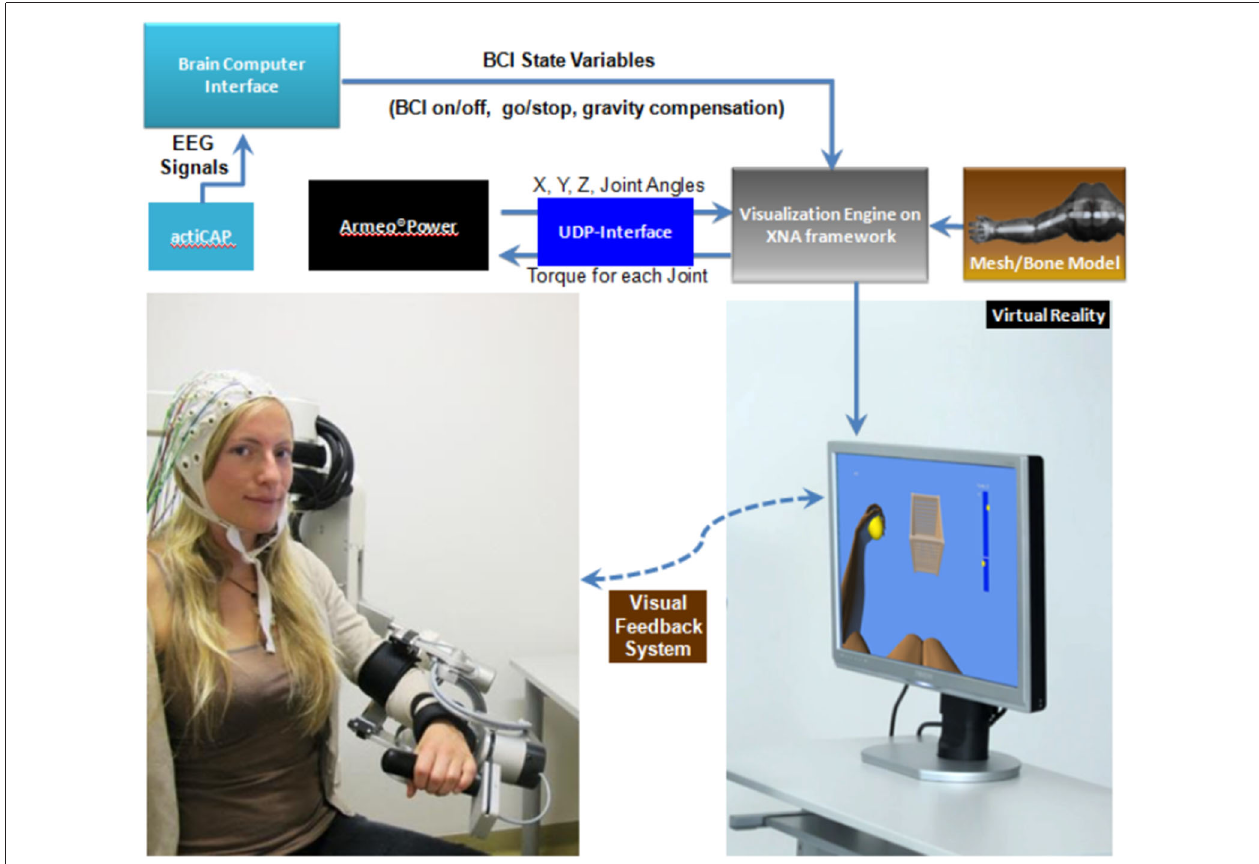
FIGURE 2 | Schematic overview of the setup. EEG signals from an ActiCAP system are analyzed by the BCI software (BCI2000) which controls the visualization engine. The robot’s end-effectors position and its joint angles are transmitted to the virtual reality (VR) framework via a UDP interface. This information is integrated with a mesh model of the upper extremity, allowing for 3D virtual movements in real